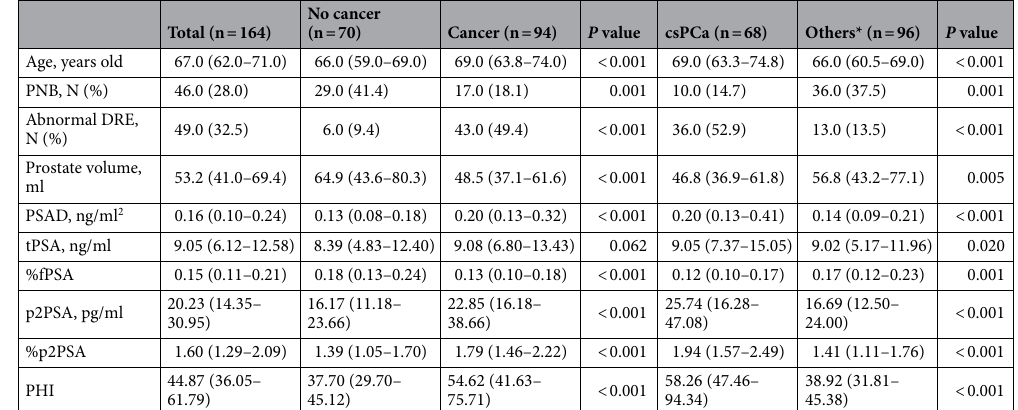
Table 1. Demographic and clinical characteristics of patients. All values given as median (IQR) and number (%). csPCa, clinically significant prostate cancer; PNB, previous negative biopsy; PSA, prostate-specific antigen; PSAD, PSA density; tPSA, total PSA; fPSA, free PSA; %fPSA, fPSA to tPSA ratio; p2PSA, [-2]pro PSA; %p2PSA, p2PSA to fPSA ratio; PHI, Prostate Health Index. Others*: no cancer + Gleason sum 6 prostate cancer.